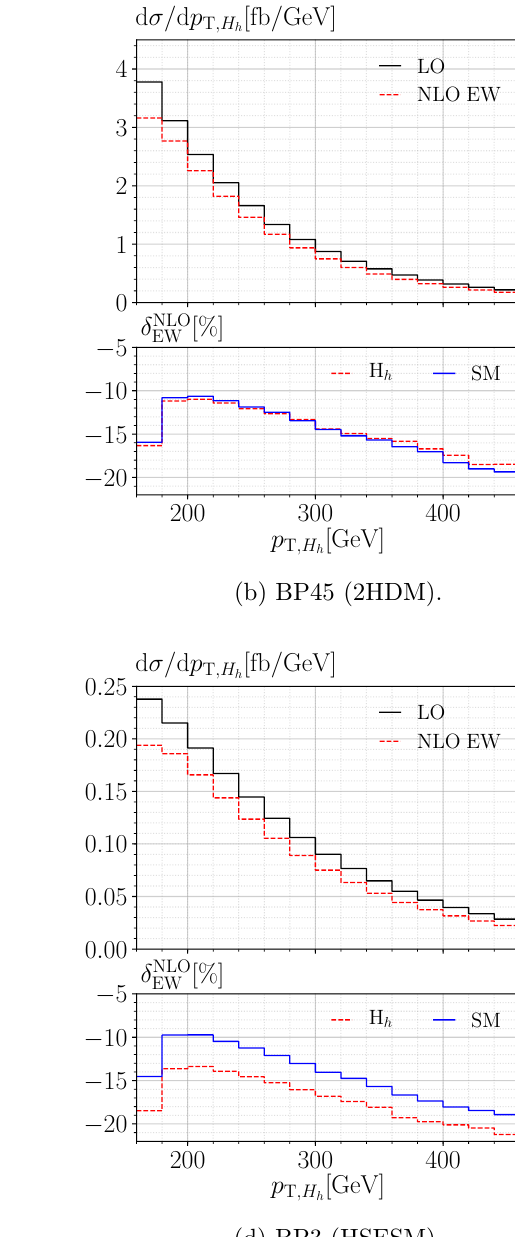
T ;H h for heavy Higgs